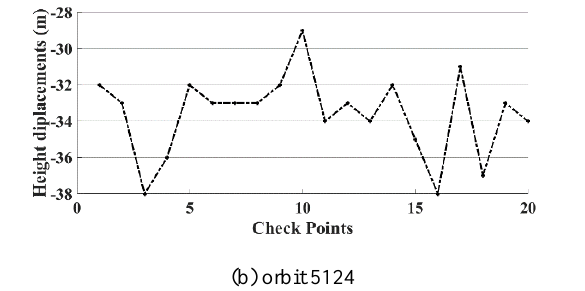
Figure 14. Height accuracy comparison between the generated DEM and the HRSC Level-4